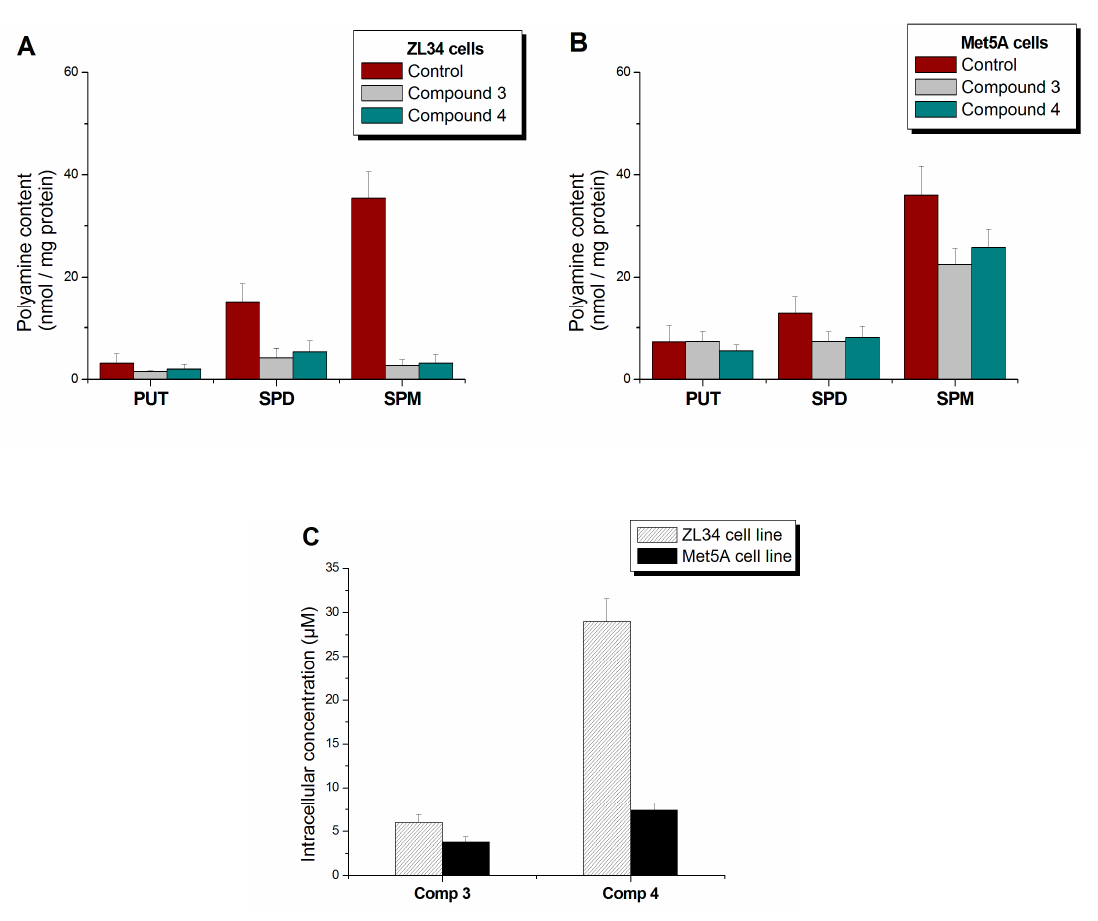
Figure 4. Changes in the polyamine levels of cells A) ZL34 and B) Met5A, after treatment with 60 µ Μ of compound 3 or 4 . C) Intracellular concentration of compounds 3 and 4 , detected in cell